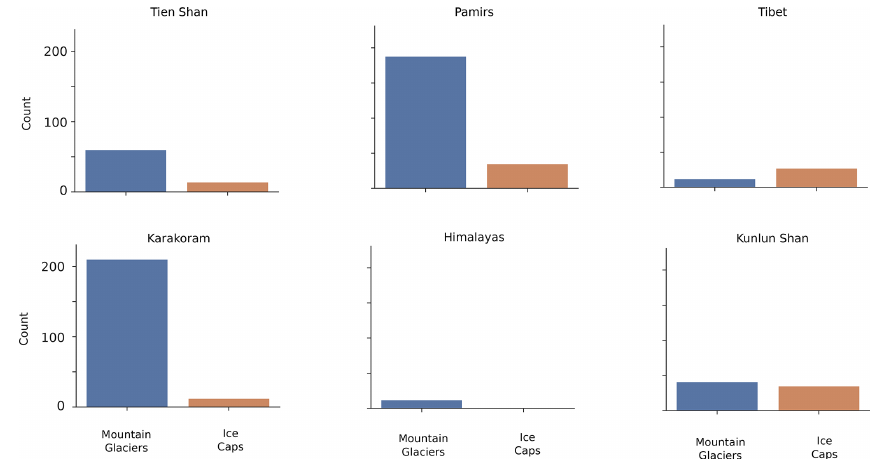
Figure 8. Distributions of surge-type glacier types for each of the greater HIMAP regions. Note that the Tibetan Mountains are the only region where ice cap outlet glaciers are more represented than mountain glaciers, with a ratio of